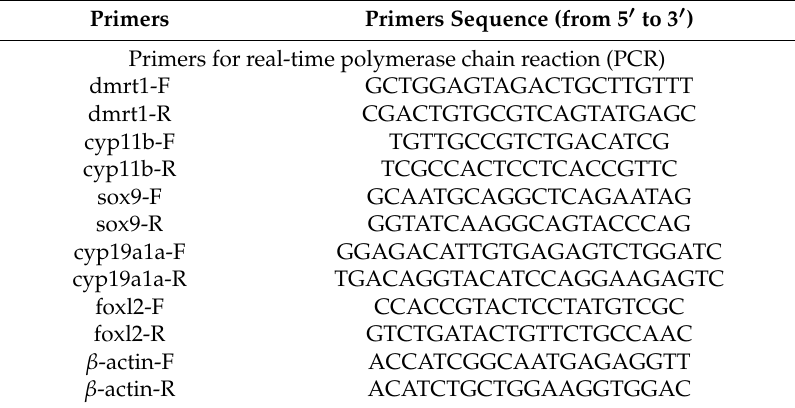
Table 2. Nucleotide sequences of the primers used in this study. Primers Primers Sequence (from 5 (cid:48) to 3 (cid:48)